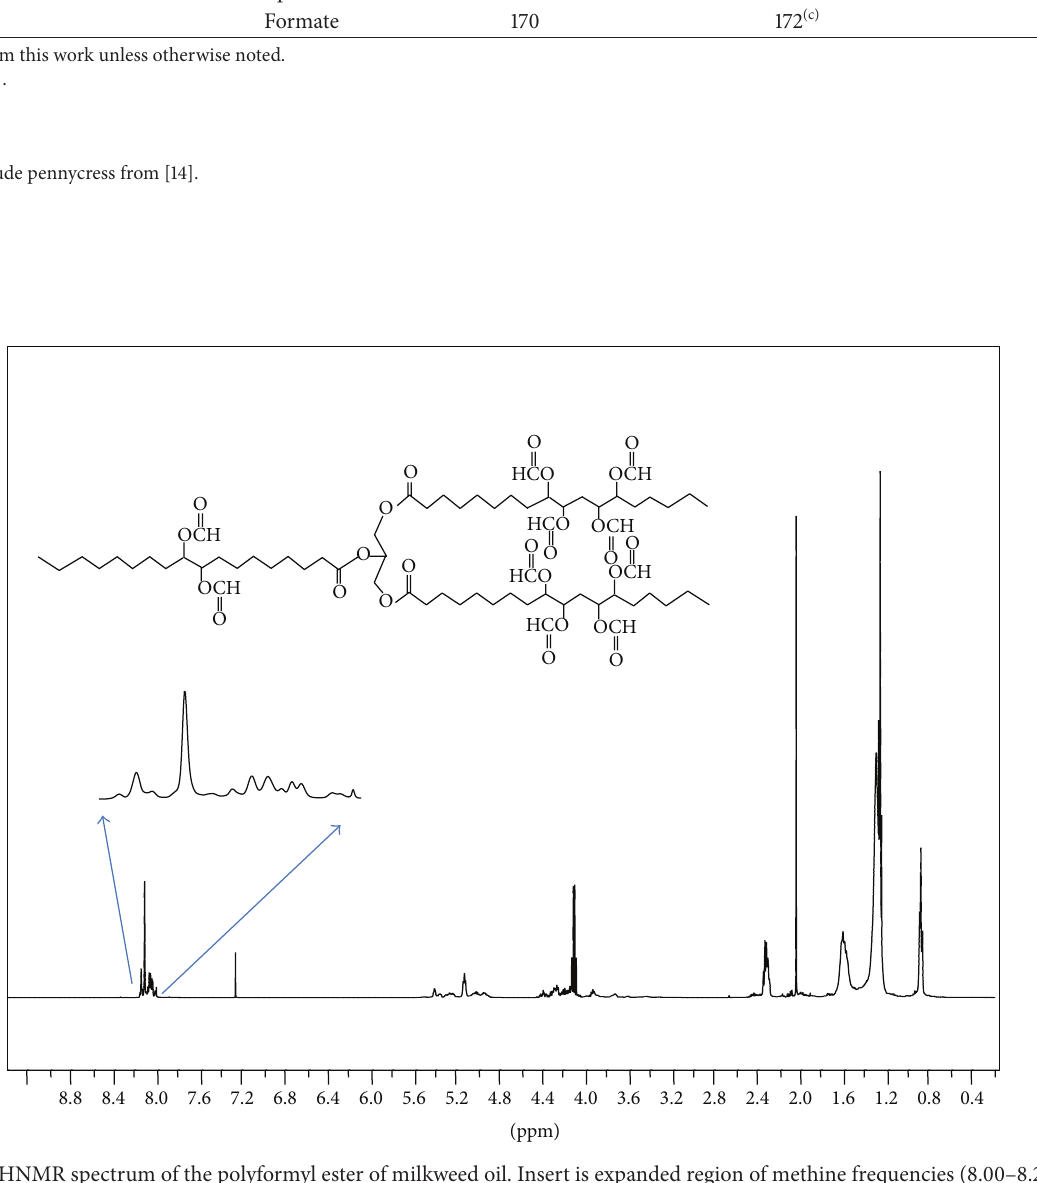
Figure 4: 1 HNMR spectrum of the polyformyl ester of milkweed oil. Insert is expanded region of methine frequencies (8.00–8.20